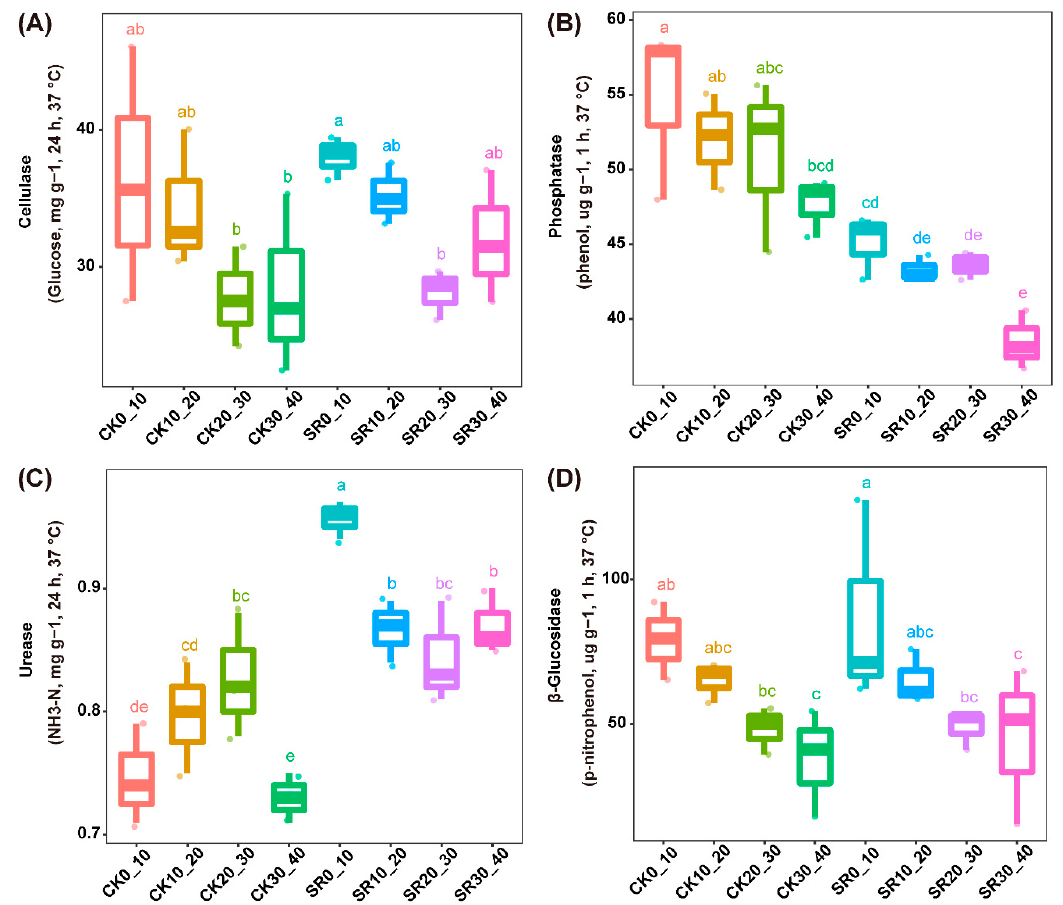
Figure 2. Soil enzymatic activities such as cellulase ( A ), phosphatase ( B ), urease ( C ) and β -glucosidase ( D ) at 0–40-cm depths under sugarcane straw retention (SR) compared to the control (CK). Error bars in boxplots with different lowercase letters show significant differences between treatments (Tukey test, p < 0.05).